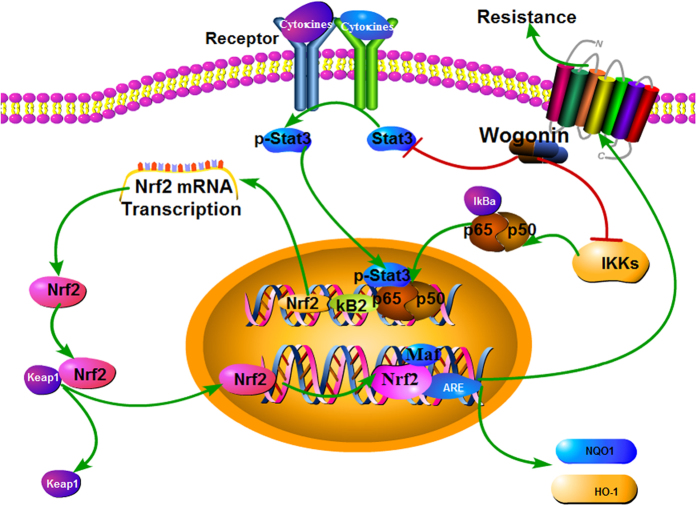
Schematic representation of the molecular mechanisms proposed in the reversal effect of Wogonin via inhibition of p-Stat3/κB2/Nrf2 in resistant CML cells.